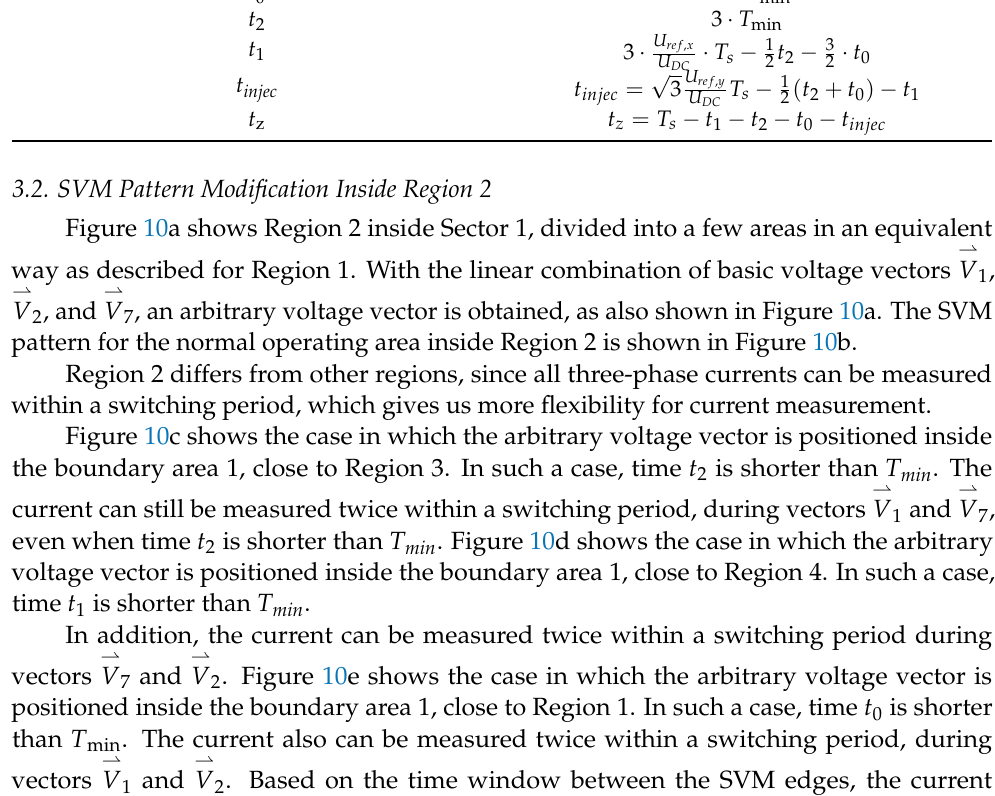
Table 8. Time calculation for the proposed SVM pattern for Region 4 applied inside the inner hexagon.